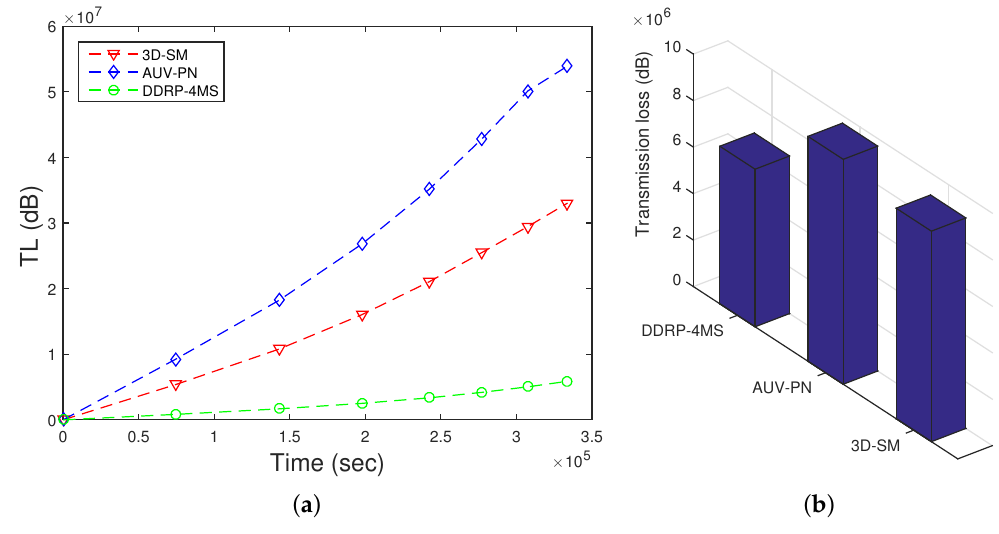
Figure 12. TL of network. ( a ) when all nodes die; ( b ) when first node